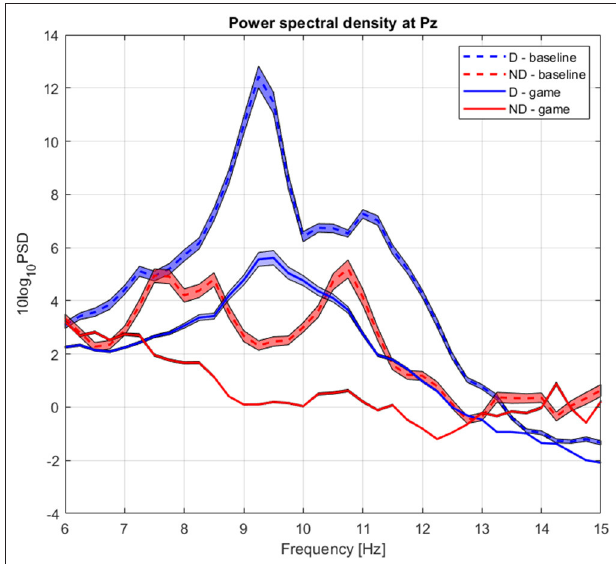
FIGURE 3 | Group average power spectrum density during baseline (dashed) and gaming (continuous) for D (blue) and ND (green) players. Shaded area = standard deviation of the